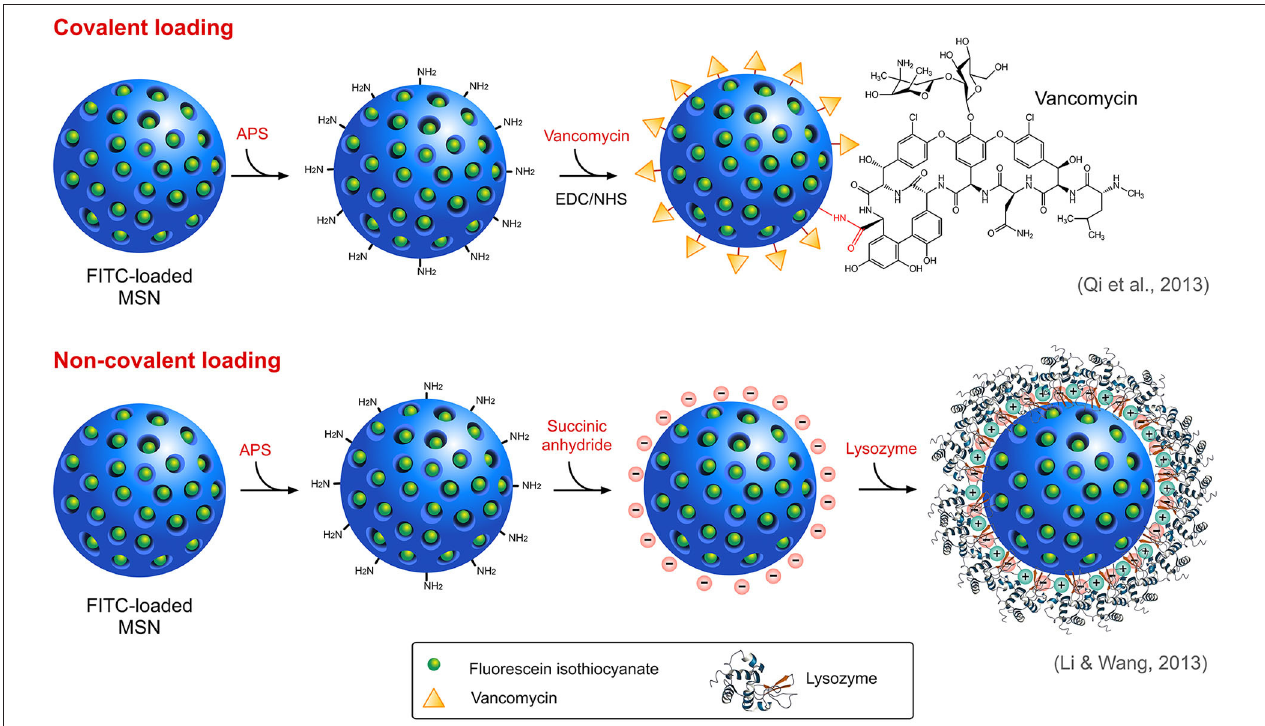
FIGURE 4 | Different modes of loading of antimicrobials onto